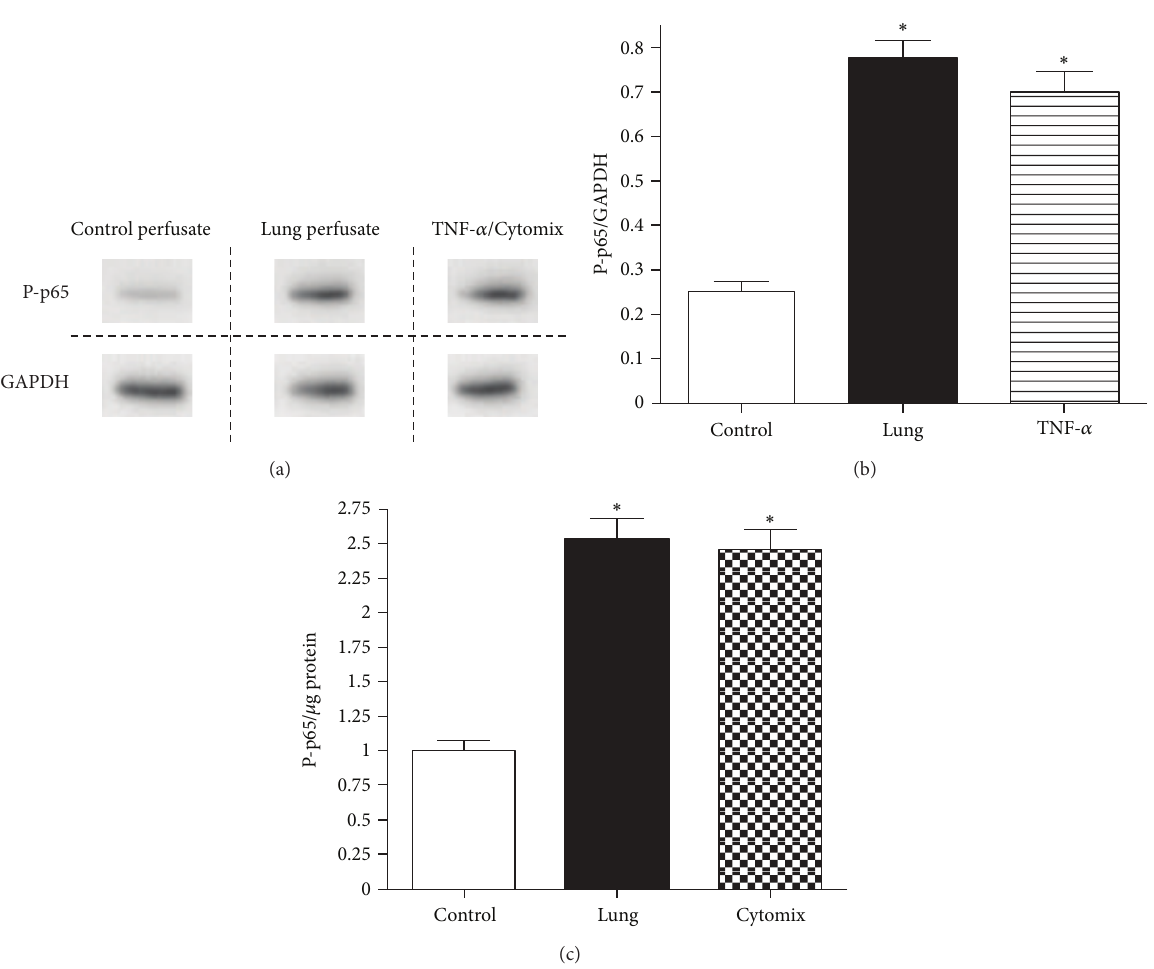
Figure 2: Activation of NF- 𝜅 B in MLEC exposed to control uncirculated perfusate, lung perfusate, and TNF- 𝛼 /cytomix. (a) Representative western blot and (b) densitometry of P-p65 relative to GAPDH expression. (c) Activation of NF- 𝜅 B employing phospho-p65 (Ser536) ELISA. ( ∗ 𝑃 < 0.05 versus control, ±